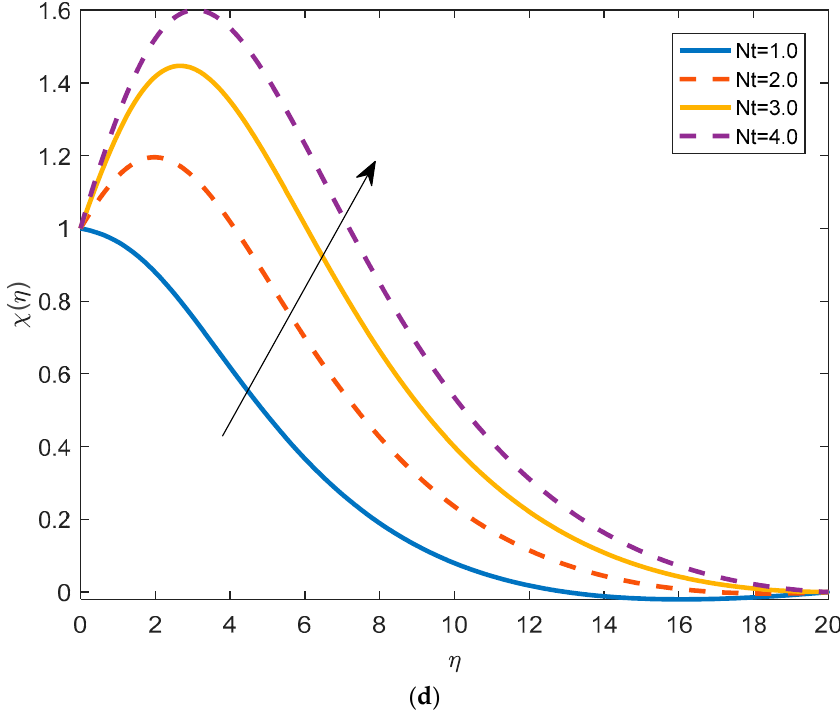
Figure 5. ( a ): Velocity distribution for various Nt when Rb = 0.1, Nb = 2.0, M = 0.1, Pr = 1.5, W e = 0.2, λ = 0.2, Sc = 0.2, Sc n = 0.2, Pe = 1.0, K p = 0.5 at α = π /6. ( b ): Temperature distribution for various Nt when Rb = 0.1, Nb = 2.0, M = 0.1, Pr = 1.5, W e = 0.2, λ = 0.2, Sc = 0.2, Sc n = 0.2, Pe = 1.0, K p = 0.5 at α = π /6. ( c ): Concentration distribution for various Nt when Rb = 0.1, Nb = 2.0, M = 0.1, Pr = 1.5, W e = 0.2, λ = 0.2, Sc = 0.2, Sc n = 0.2, Pe = 1.0, K p = 0.5 at α = π /6. ( d ): Density of motile micro-organisms for various Nt when Rb = 0.1, Nb = 2.0, M = 0.1, Pr =1.5, W e = 0.2, λ = 0.2, Sc = 0.2, Sc n = 0.2, Pe = 1.0, K p = 0.5 at α = π /6.